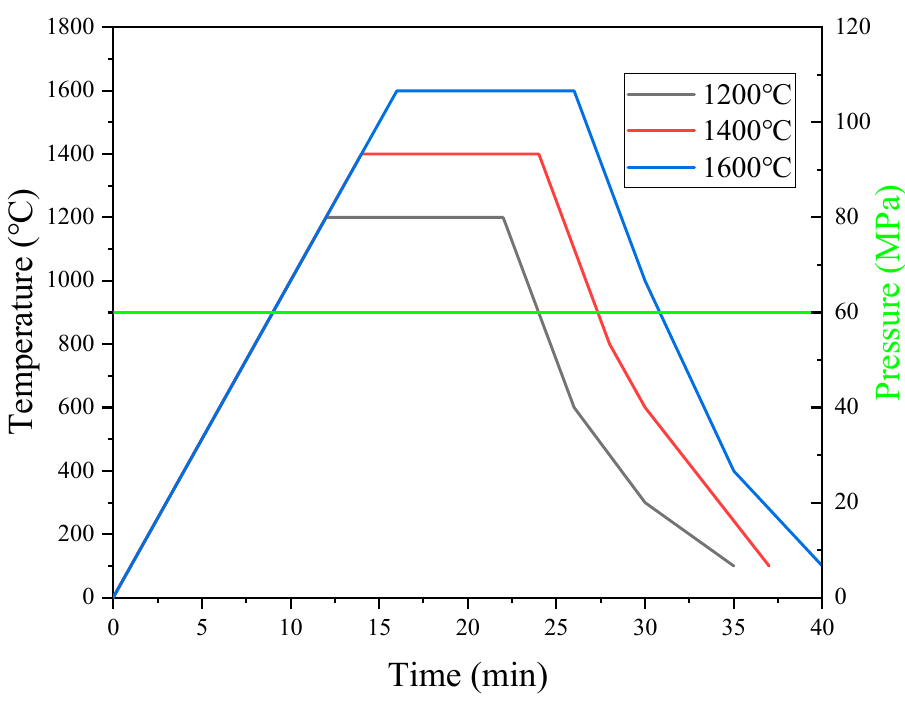
Figure 1. Curves of SPS sintering process.